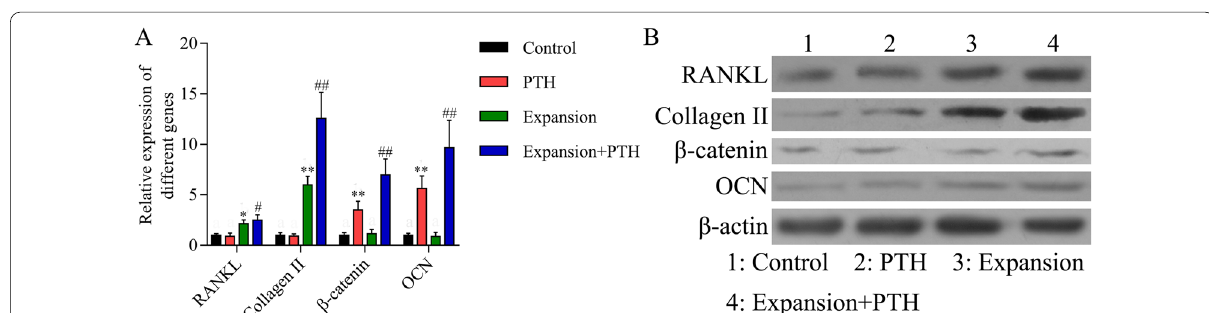
Fig. 6 PTH up-regulated RANKL, β-catenin, collagen II and OCN expressions in maxillary expansion model rats. The rats were divided into control, PTH, expansion and expansion PTH groups, respectively. A The mRNA expression levels of RANKL, β-catenin, collagen II and OCN were analyzed + by RT-qPCR assay, * P < 0.05, ** P < 0.01 versus control group; # P < 0.05, ## P < 0.01 versus expansion group. B RANKL, β-catenin, collagen II and OCN expressions were examined by western blot assay in each group. β-actin was used as internal reference. Different letters marked were considered to have significant difference between the two